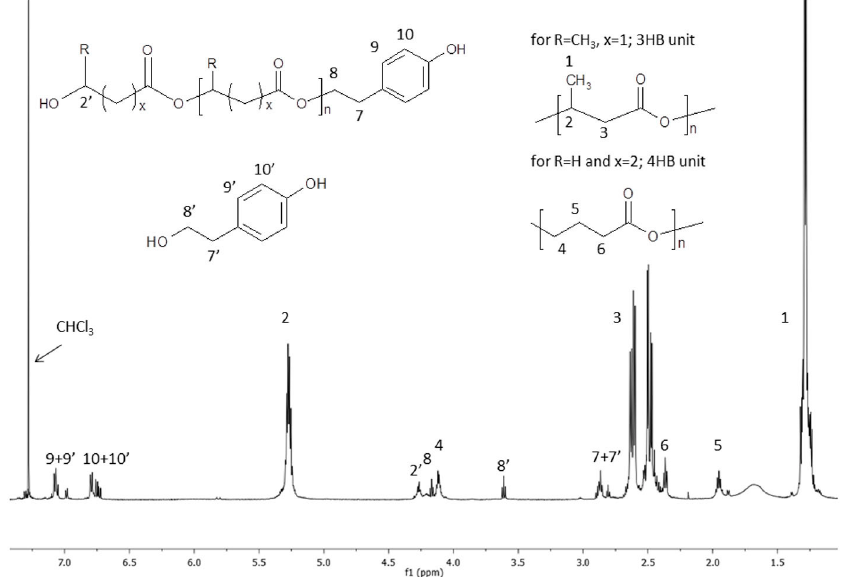
Figure 1. The 1 H NMR spectrum of Sample 2 from Table 1.